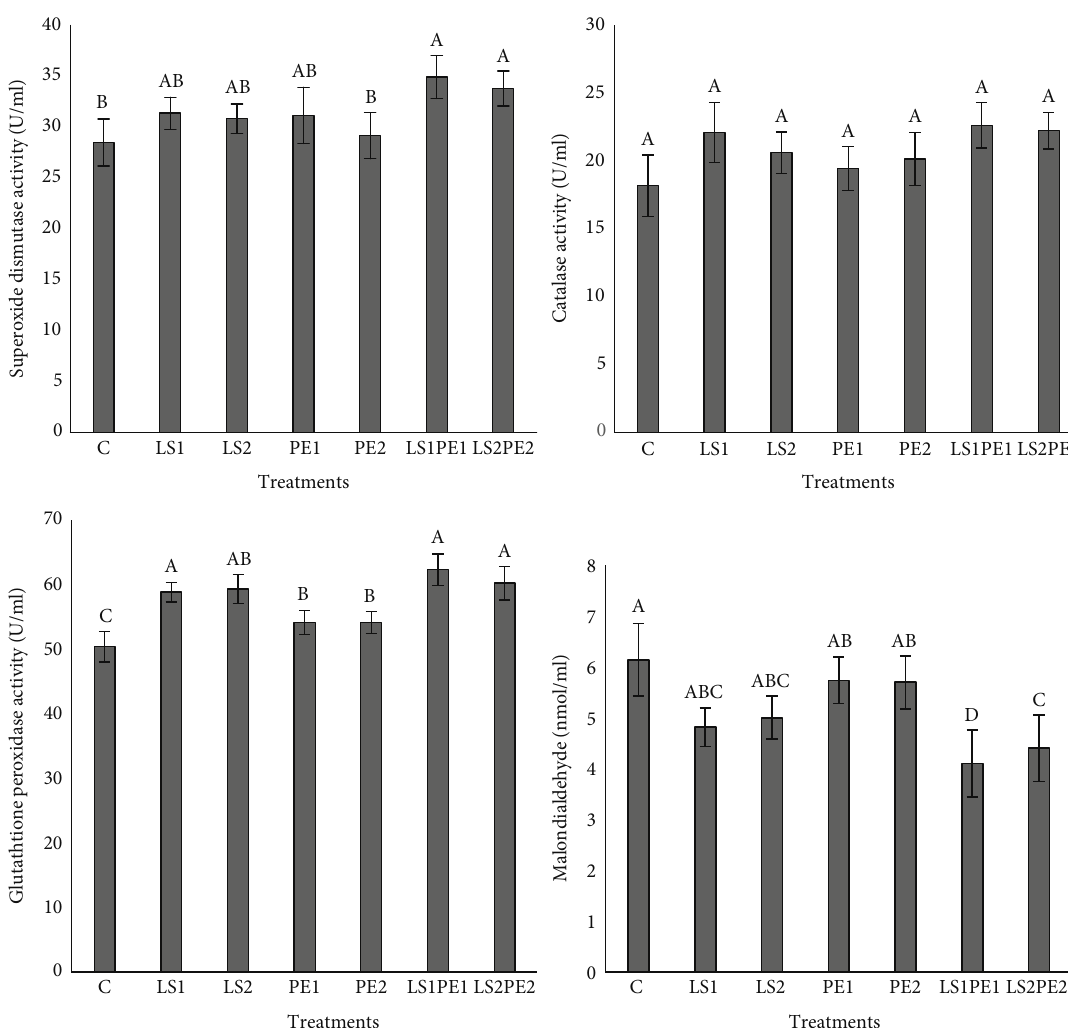
Figure 3: Antioxidant enzymes activities of cray fi sh narrow-clawed cray fi sh ( P. leptodactylus ) fed with basal diet and supplemented with LS1 ( L. salivarius , 1 × 10 7 CFU/g), LS2 ( L. salivarius , 1 × 10 9 CFU/g), PE1 (Pectin, 5g/kg), and PE2 (Pectin, 10g/kg), LS1PE1 ( L. salivarius , 1 × 10 7 CFU/g+ Pectin, 5g/kg), and LS2PE2 ( L. salivarius , 1 × 10 9 CFU/g +Pectin, 10 g/kg) for 18 weeks. Bars represent the mean ± SD ( n = 3 ). Di ff erent superscripts show signi fi cant di ff erences between the experimental